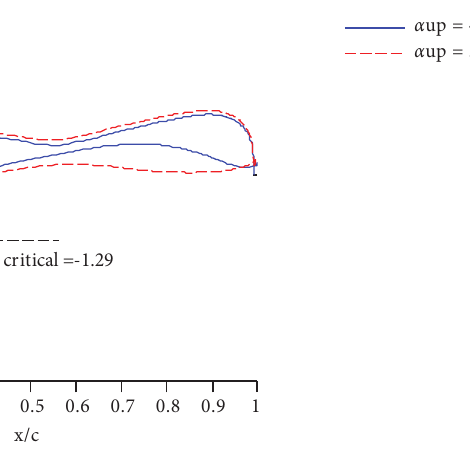
Figure 31. Pressure Coefficient distribution over the airfoil obtained from numerical solution, Mach = 0.6.